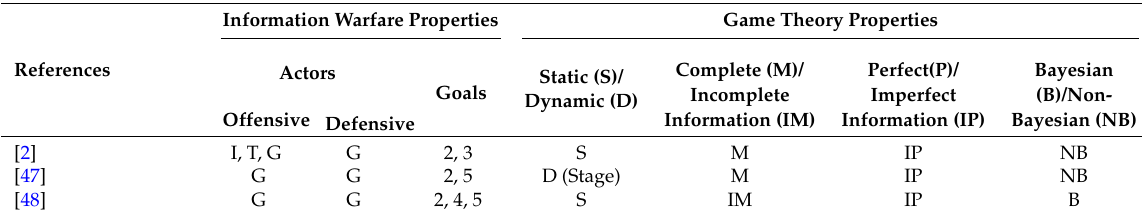
Table 3. List of Command and Control